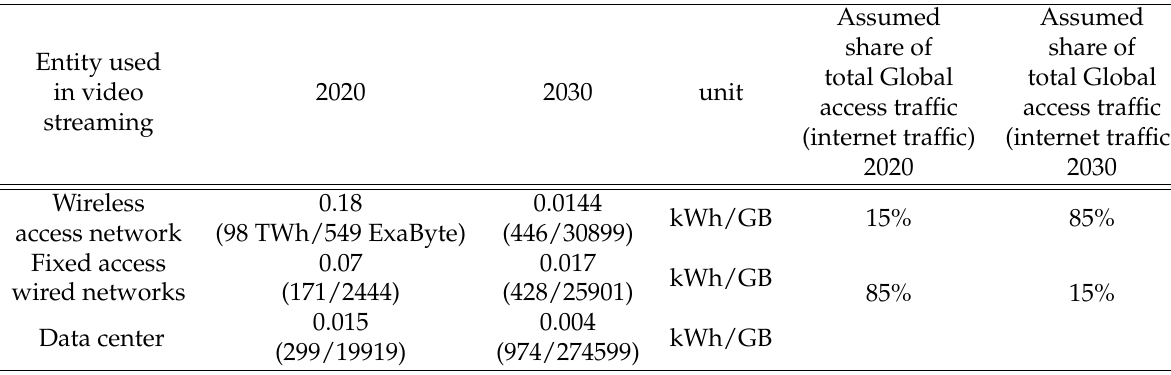
Table 7. 2020 and 2030 key electricity intensity indicators relevant for video